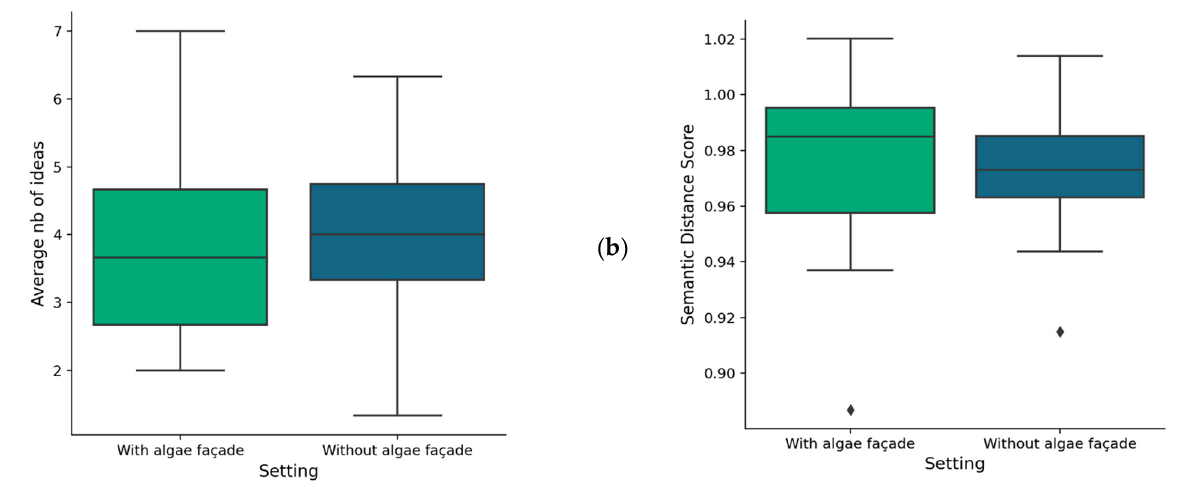
Figure 5. Effect of the microalgae facade on the number of ideas participants formulate (average across participants) ( a ) and their average semantic distance (score range from 0 to 2) ( b ); the microalgae façade did not have a greater impact on divergent thinking than the controlled